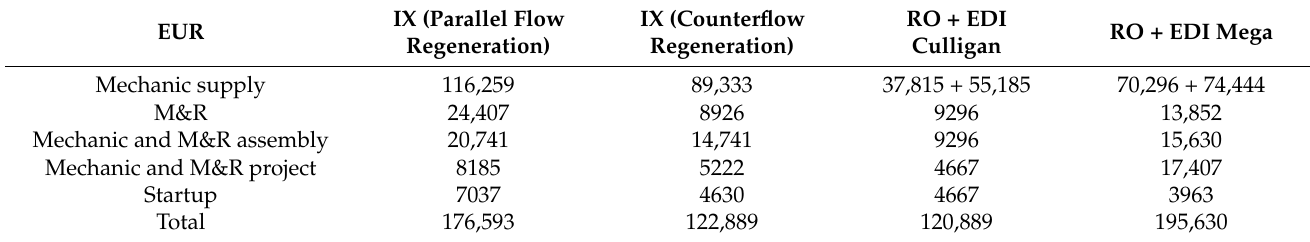
Table 3. CapEx of IX vs. RO + EDI (2010) (EDI of company Mega constitutes former EDI-X modules, which have been recently substitute by MPure TM